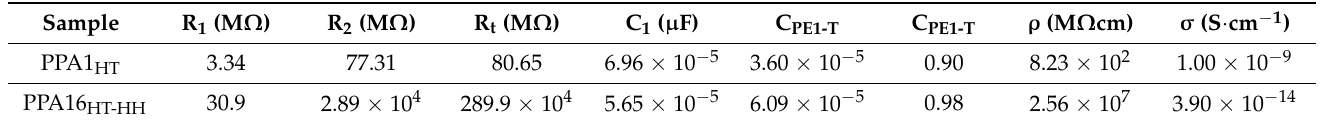
Table 5. Tuning parameters using the equivalent circuit model (R 1 , R 2 , C 1 , C PE ). R t and ρ parameters were calculated using the adjustment